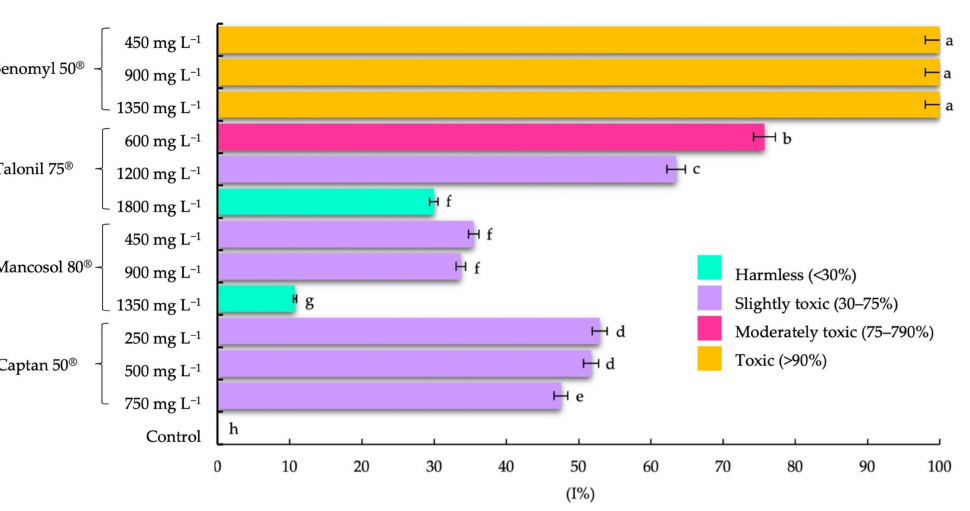
Figure 5. The effect of four fungicides at different concentrations according to the classification scale established by IOBC. Means followed by the same letter are not significantly different for p ≤ 0.05 according to Tukey test. [Reproduced with permission from Viñuela et al., Phytoma; published by PHYTOMA-España,